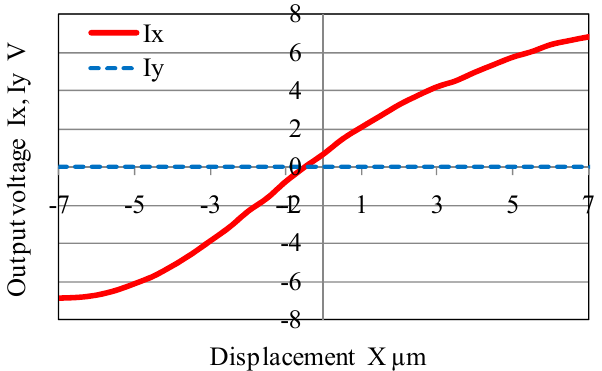
Figure 4. Changes in output voltages I X and I Y induced by displacement in ± X ‐ direction.